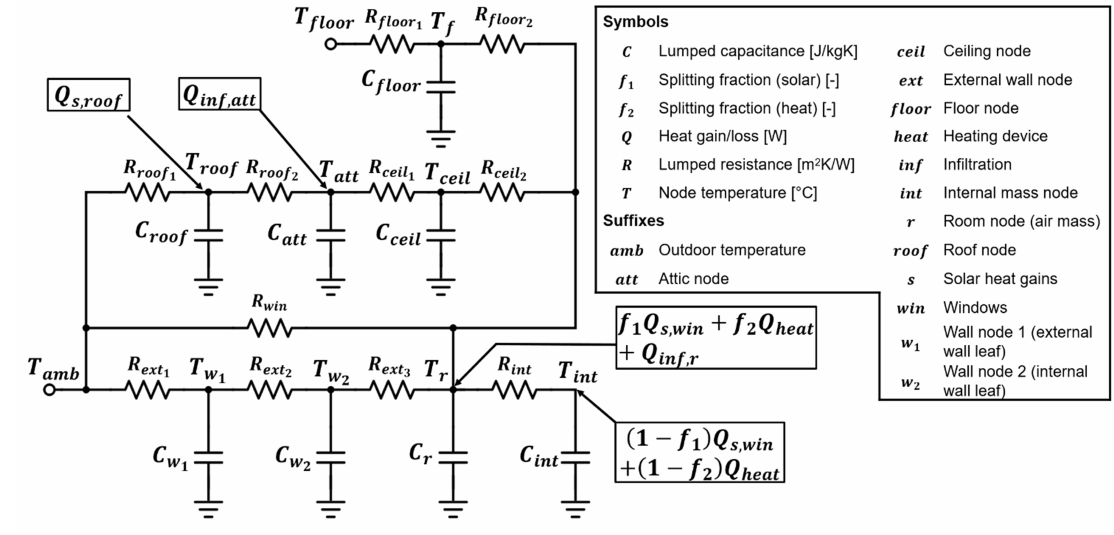
Figure 10. Heterogeneous lumped capacitance models proposed for the calibration technique